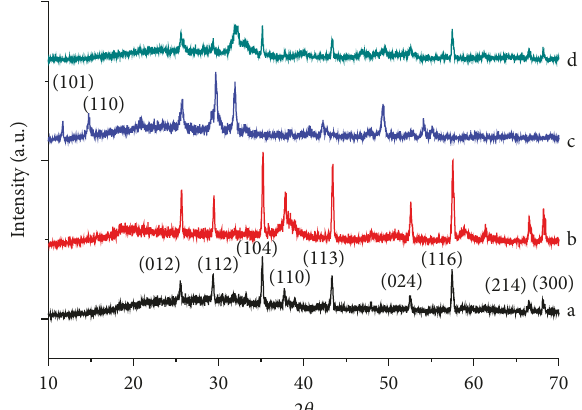
Figure 2: XRD pattern of as-synthesized compounds: (a)